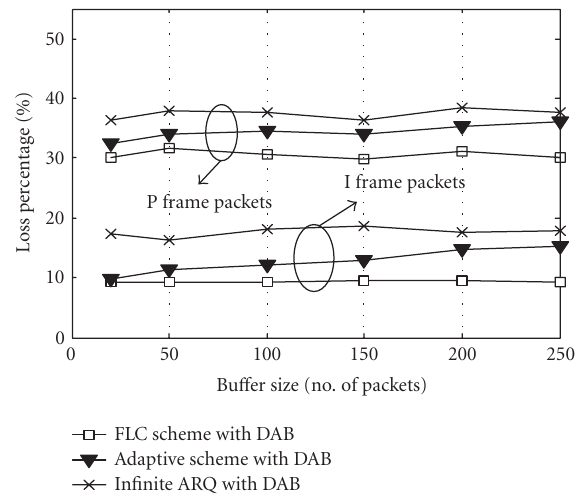
Figure 11: Packet loss rates for three DAB-based schemes, with changing bu ff er size.